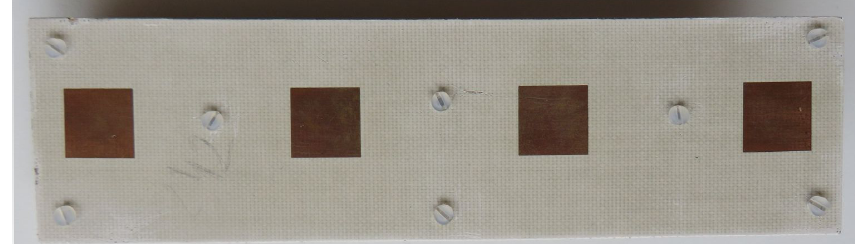
Figure 18. Fabricated antenna array—top